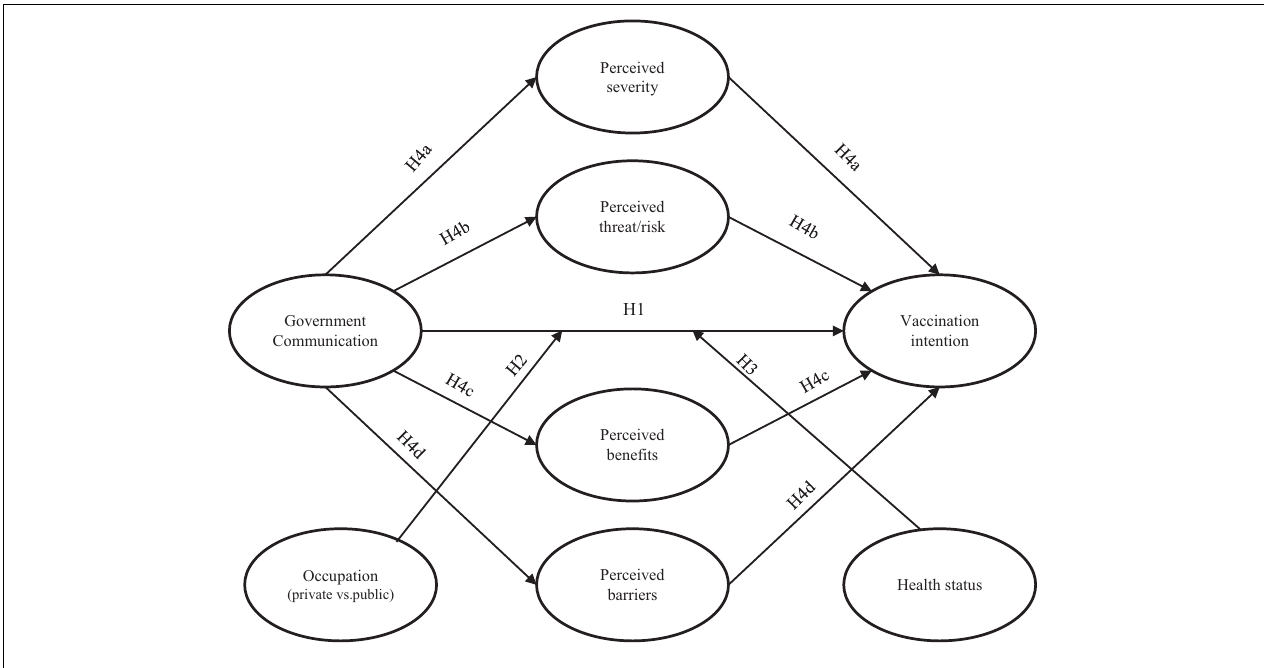
FIGURE 1 | Research